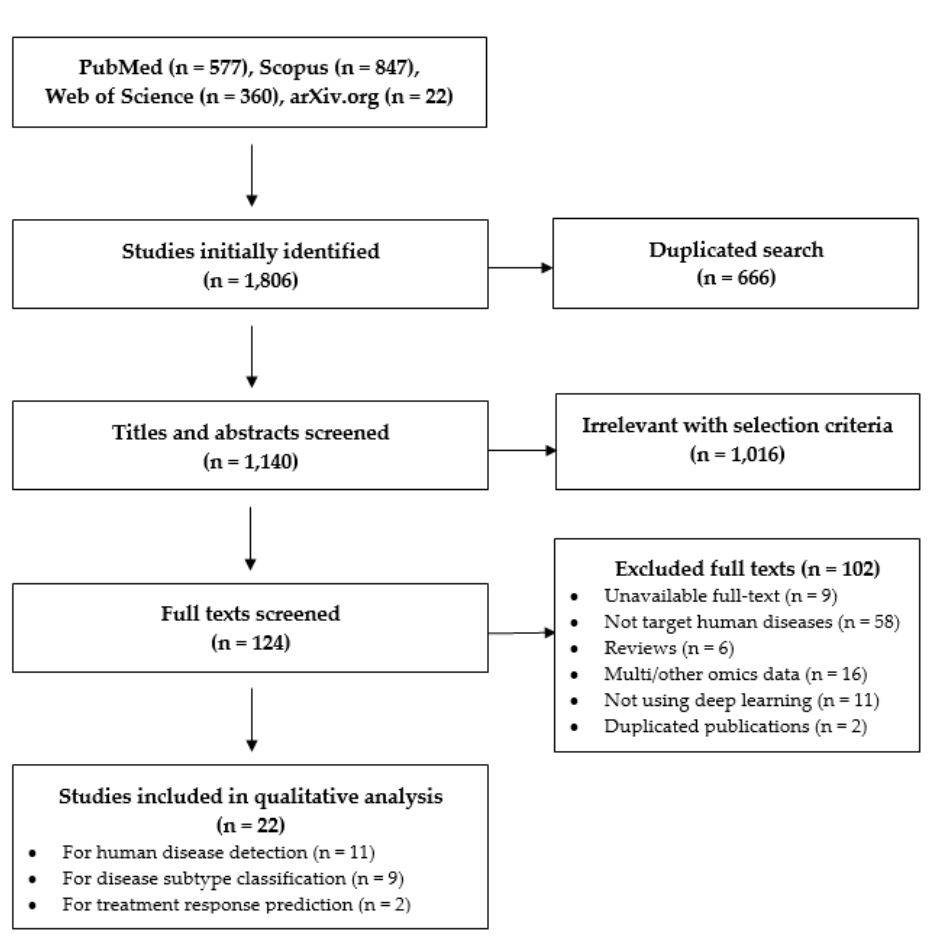
Figure 1. PRISMA flow for study selection.